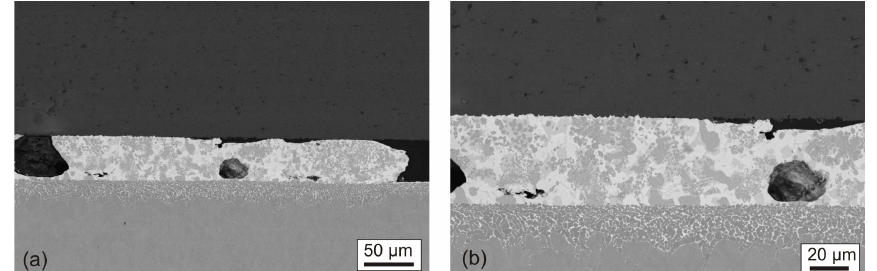
Figure 8. SEM images of Kovar–Al 2 O 3 joints brazed with Incusil-25-ABA at 650 ◦ C for 10min.